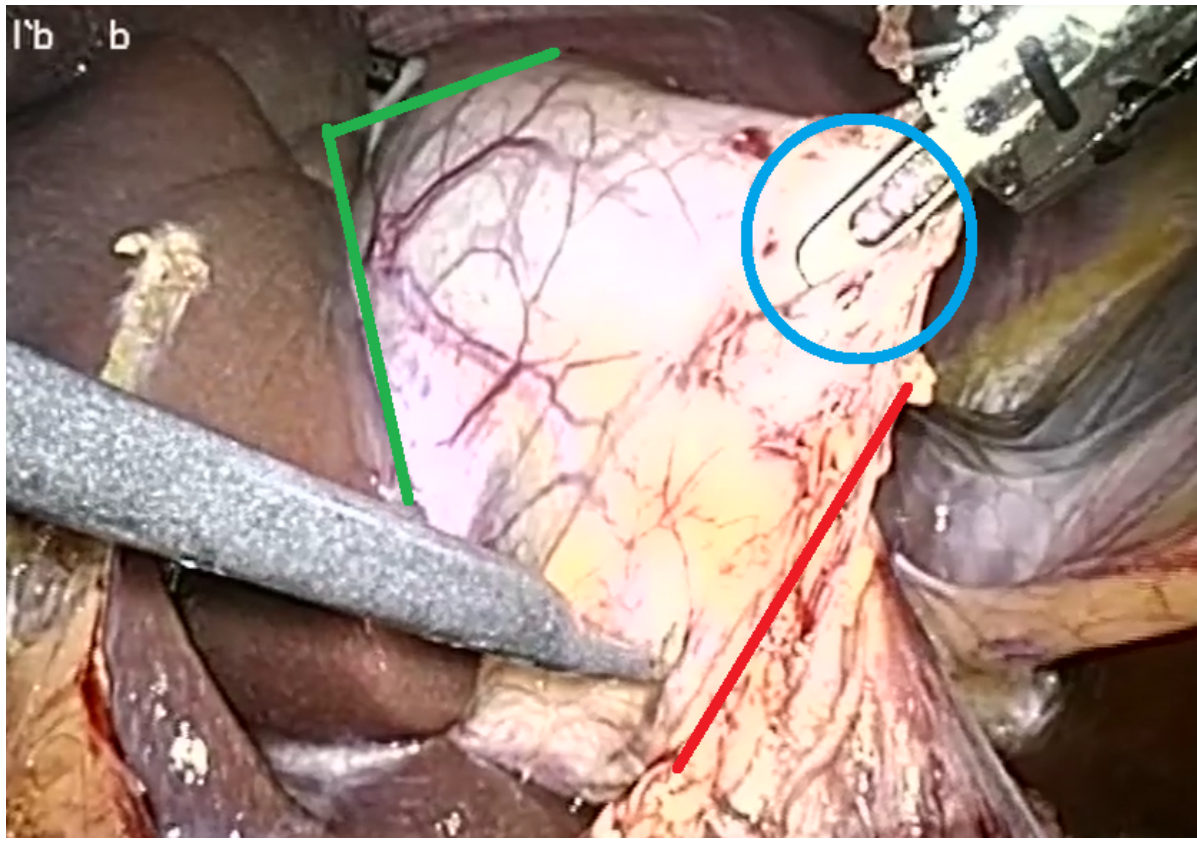
Figure 1. Surgical